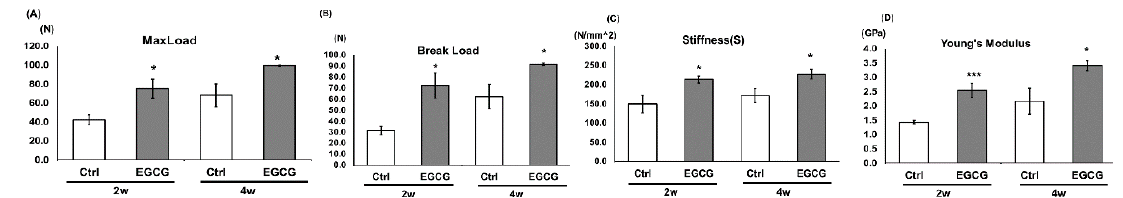
Figure 2. EGCG increased the bone mechanical properties of the fractured tibia. The results of mechanical testing showed that the maximal load ( A ), break load ( B ), stiffness ( C ), and Young’s modulus ( D ) (at weeks 2 and 4) were significantly increased after the treatment of EGCG. All data are expressed as mean ± standard error. * p < 0.05 versus control group after treatment. *** p < 0.001 versus control after treatment.